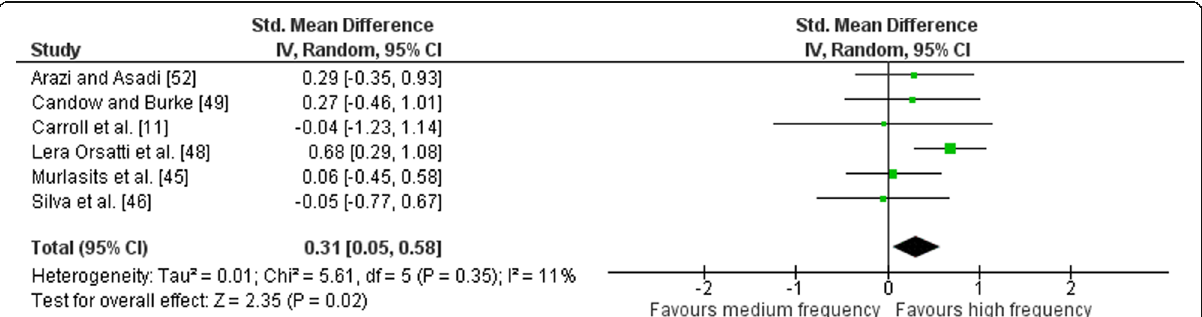
Fig. 8 Medium vs. high weekly training frequency. Pre- vs. post-mean ES strength difference on multi-joint and isolation exercise. The vertical line indicates the overall estimate of combined multi-joint and isolation studies pre- vs. post-mean ES strength difference. Horizontal lines indicate 95% CI, squares estimates, whereas square size is proportional to sample size, and rhombs ’ meta-analytically pooled estimates